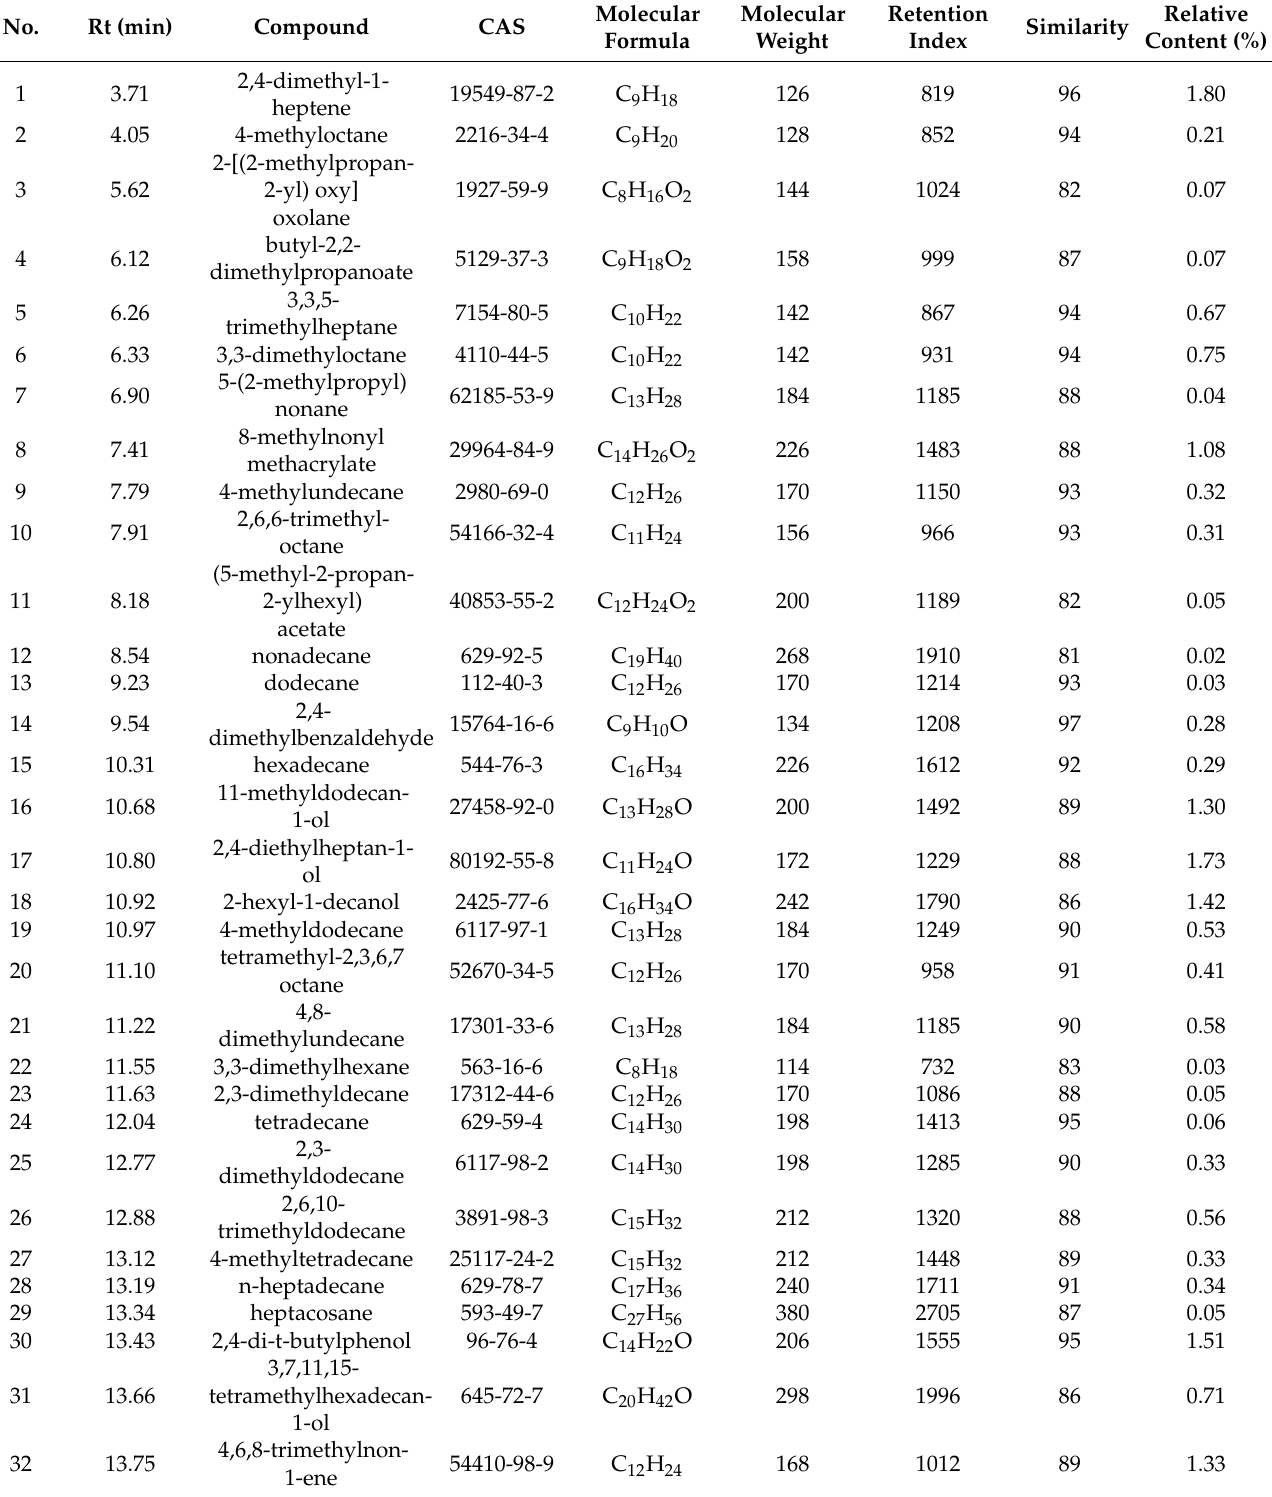
Table 1. Volatile chemicals of S. tetrandra by GC-MS